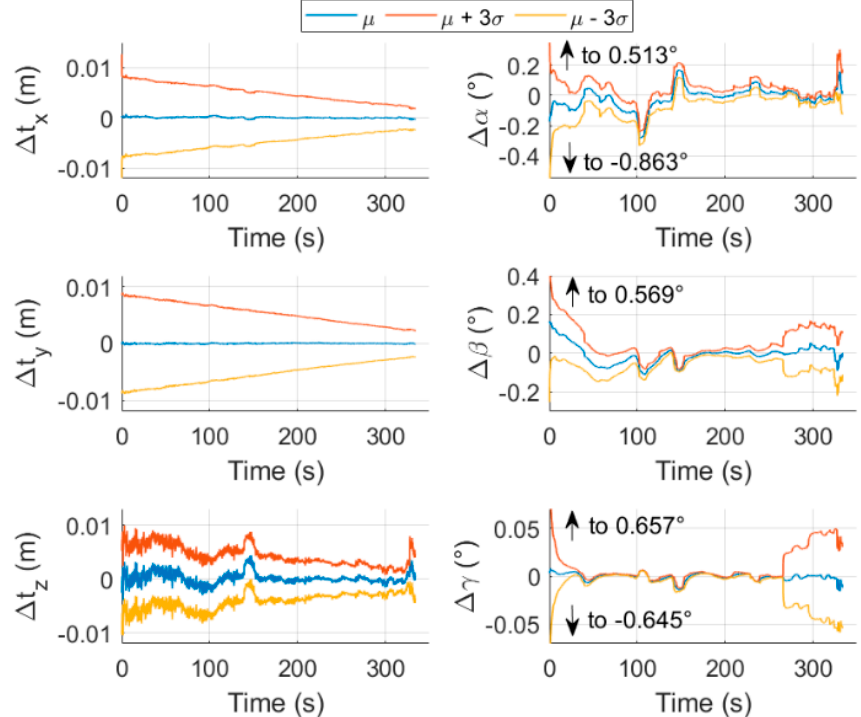
Figure 15. Temporal evolution of the mean of the errors on the pose parameters, with representation of the 3 σ intervals, for test case S7. The plots are focused on intervals about the mean values: the arrows indicate the maximum values reached by the pose initial guess at scenario start.